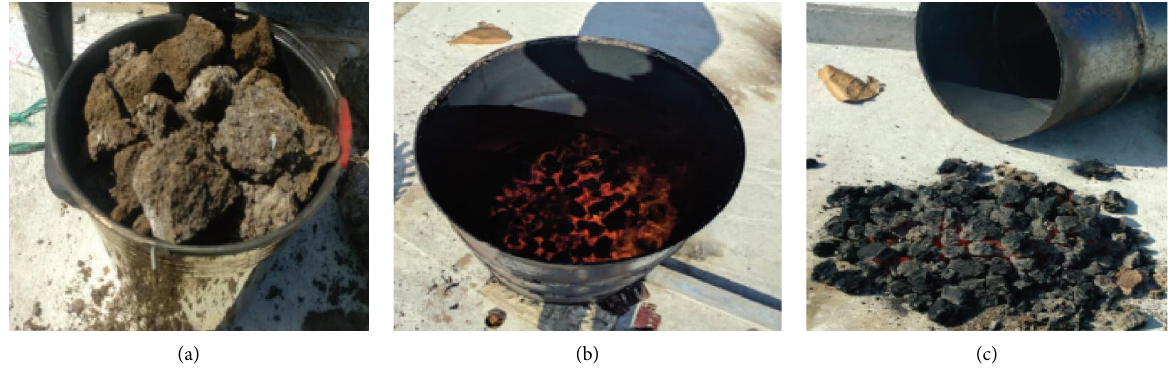
Figure 1: (a) 3–10cm of DFS. (b) Carbonization of DFS. (c) Produced